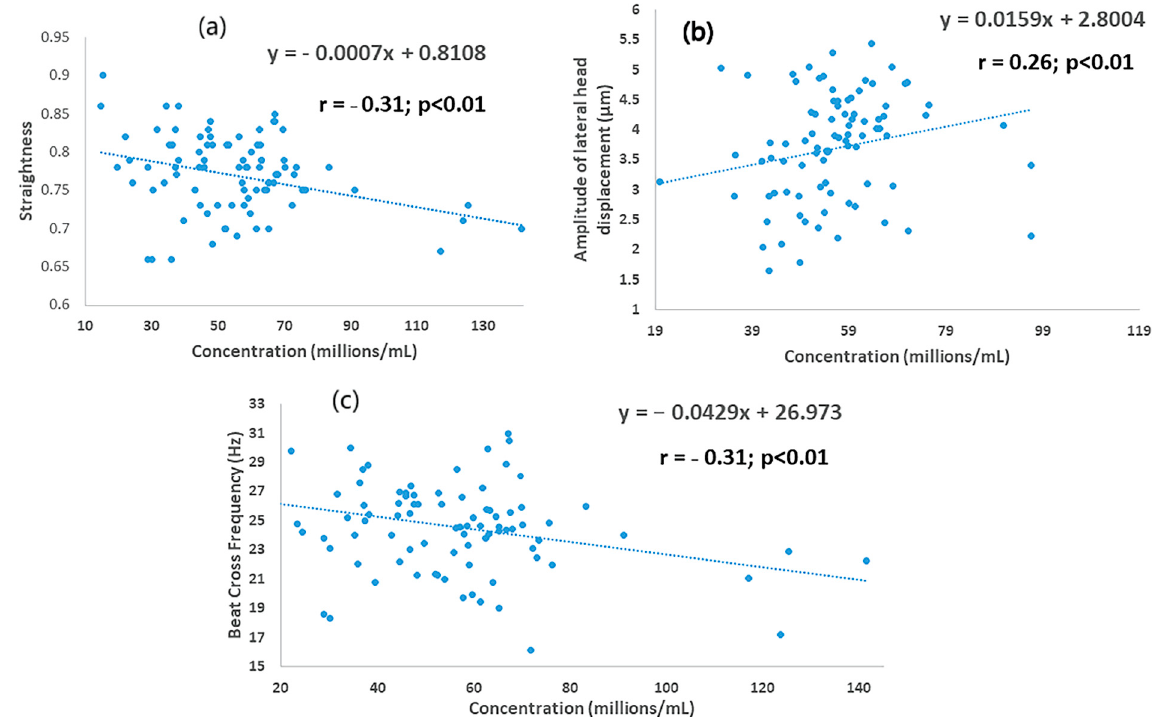
Figure 3. Association between sperm concentration and kinematics for young bull ejaculates pro- cessed by single-layer centrifugation: ( a ) straightness; ( b ) amplitude of lateral head displacement; ( c ) beat cross